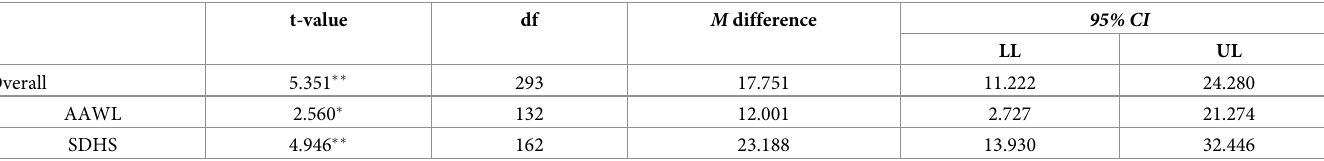
Visual identification of the dog’s primary breed by shelter staff matched the most prevalent breed identified by the Mars Wisdom Panel DogTrax analysis in 56.7% of the 384 dogs tested. Prevalence was defined as the greatest number of same breed signatures identified with two or more great-grandparents. Broadening the criteria for agreement to ignore the order in which breeds were labeled by shelter staff (i.e., primary and secondary), we found that 67.7% of these dogs had at least one breed identified by staff that agreed with DNA analysis, while 33.3% of visual breed assignments by staff did not match any of the up to eight breeds indicated in the analysis. Staff only matched both the primary and secondary breeds in 10.4% of dogs (40 out of 384). We describe these as a “complete match.” In all but four of those cases, the breeds Table 6. Significance tests for pit bull-type dogs’ and all other breeds’ length of stay (LOS) at Arizona Animal Welfare League and San Diego Humane Society. t-value df M difference 95% CI LL UL